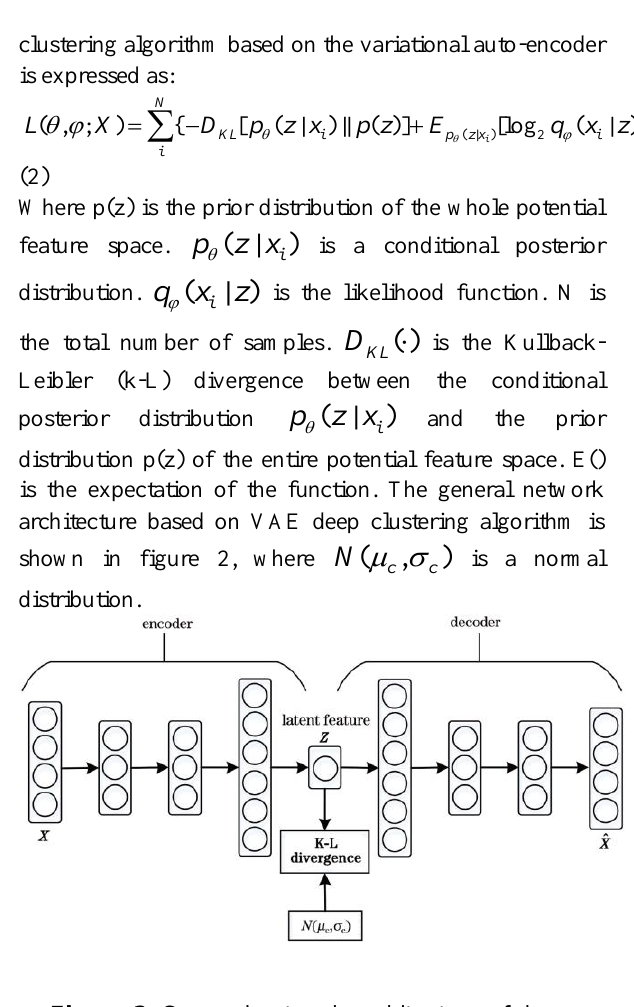
Figure 2. General network architecture of deep clustering algorithm based on